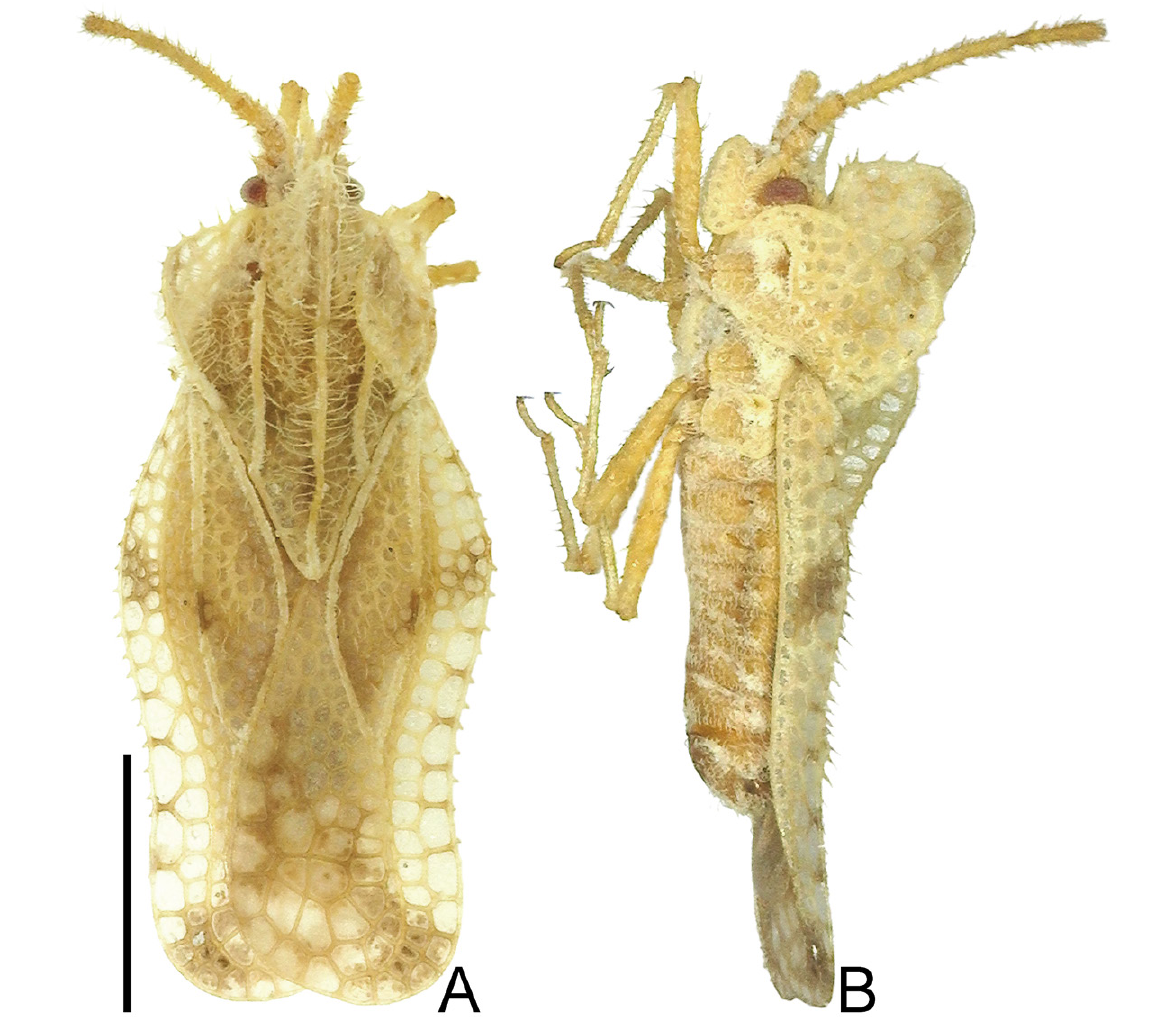
Figure 1. Dried male specimen of Lasiacantha altimitrata from Ishigaki Island, Ryukyu Islands, Japan. A. Dorsal view. B. Lateral view. Scale bar: 1.0